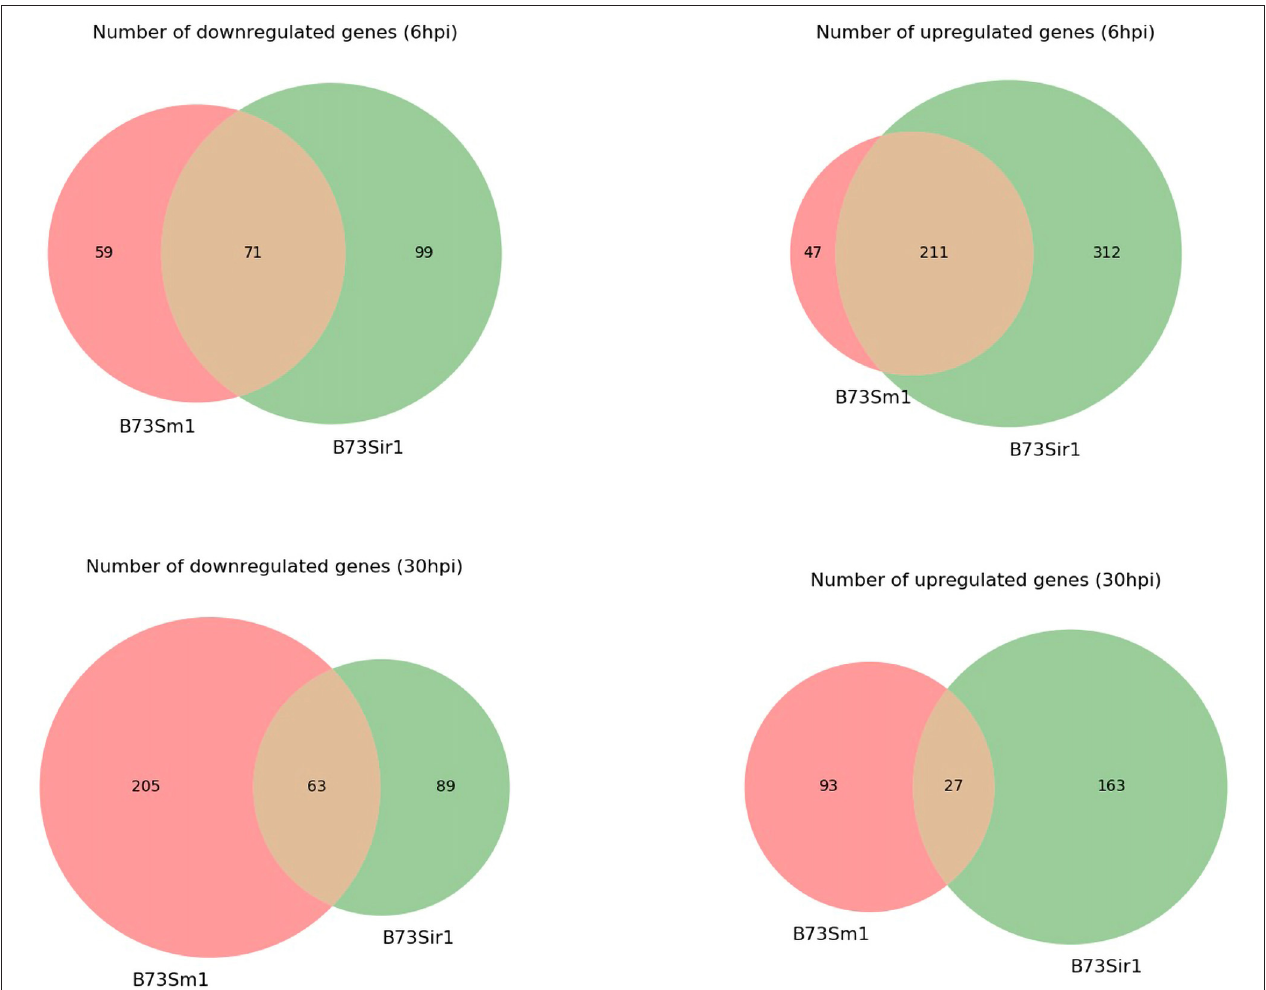
FIGURE 3 | The number of unique genes differentially expressed in 1 sm1 or 1 sir1 mutants compared to the wild type strain in the presence of B73 maize roots at 6 and 30 hpi. The red portion of each Venn diagram corresponds to genes with unique expression patterns in 1 sm1, green corresponds to genes with unique expression patterns in 1 sir1, and orange corresponds to genes with similar expression patterns in both